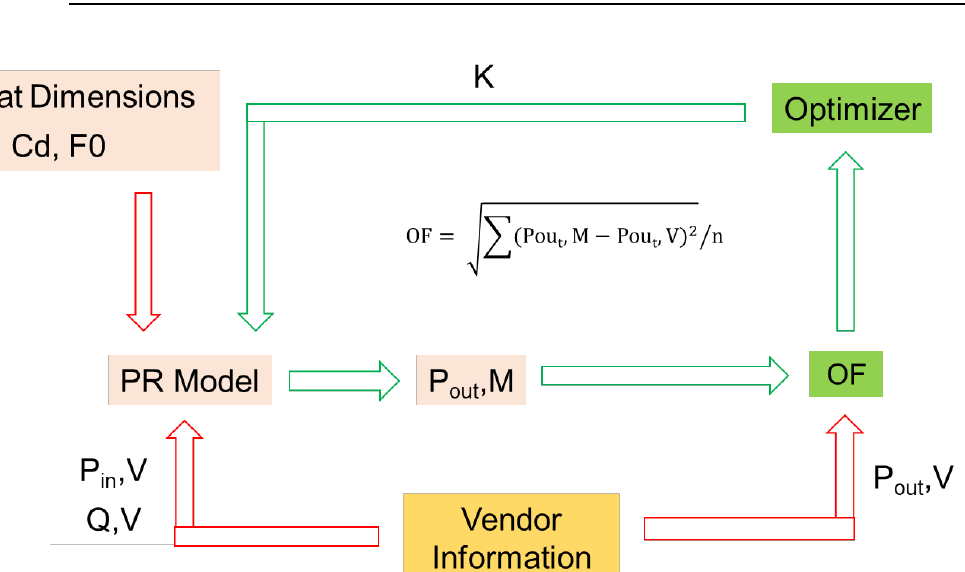
Figure 5. An overview of the developed PR fault monitoring methodologies. 5.1. Data Preprocessing